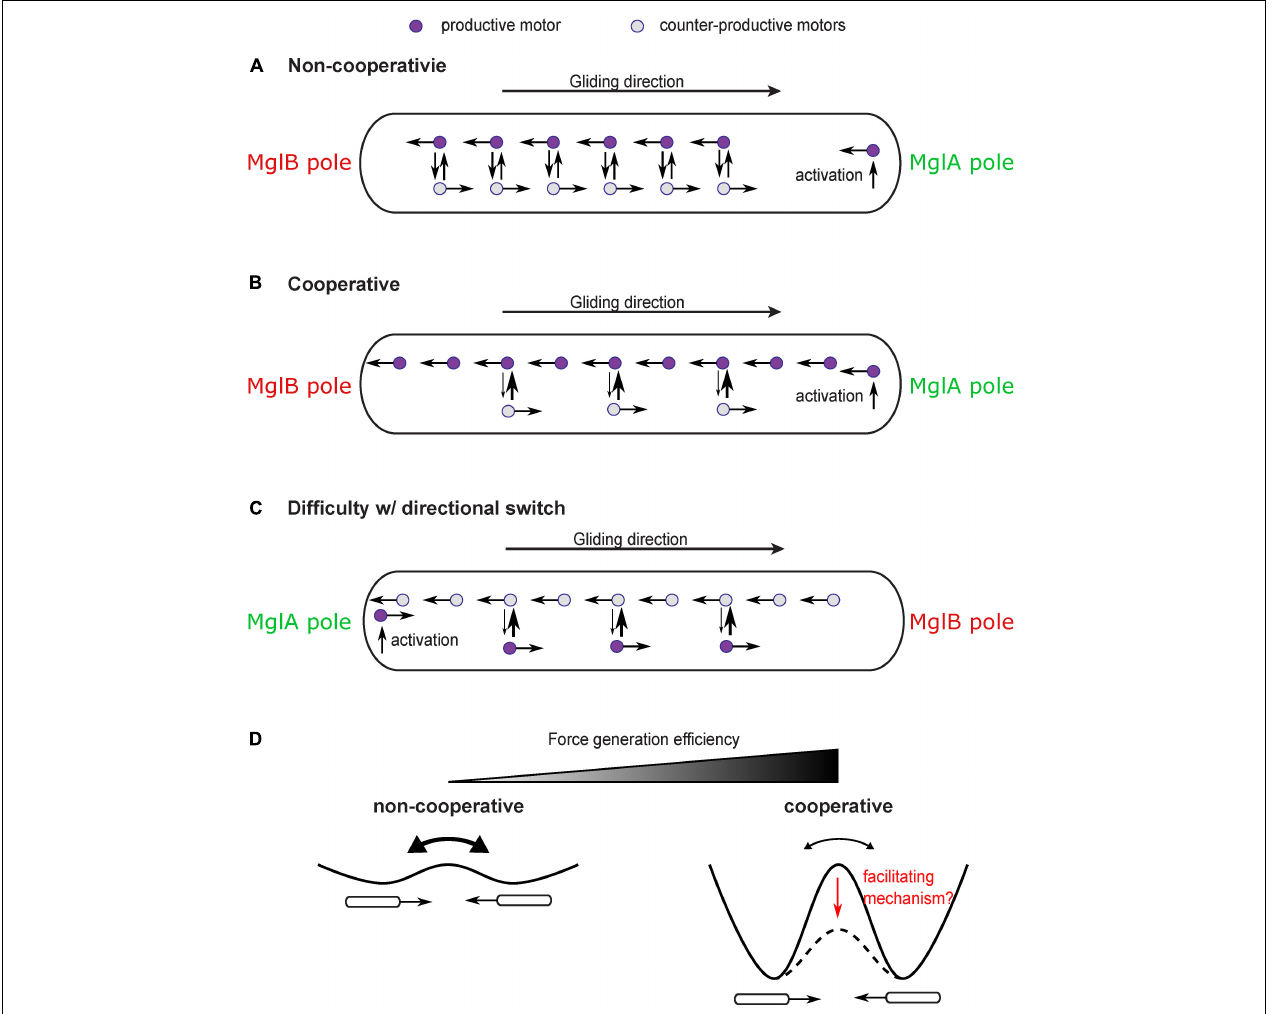
FIGURE 4 | Cooperativity of gliding motors and issue with directional switch. (A) Constant reversal of gliding motors diminishes efficiency and stability of force generation. A large number of motors would travel in the counter-productive direction and produce forces in the counter-productive direction. (B) A cooperativity mechanism makes motors more likely to convert to the direction in which more motors are traveling, which enhances the bias toward productive motors and significantly increases the efficiency and stability of force generation. (C) The cooperativity mechanism may inhibit the reversal of the moving direction of the cell after the switch of cell polarity. The motors which are activated at the new MglA pole and travel in the new productive direction may be forced by the cooperativity mechanism to join the majority that remains traveling in the old productive direction. (D) Cooperativity among motors increases efficiency and stability of force generation at the price of inhibiting reversals. Reversals can be regarded as transitions between two symmetric states with equal energy. Cooperativity increases the energy barrier between the two states. A facilitating mechanism may be needed to reduce the energy barrier and promote state transition despite